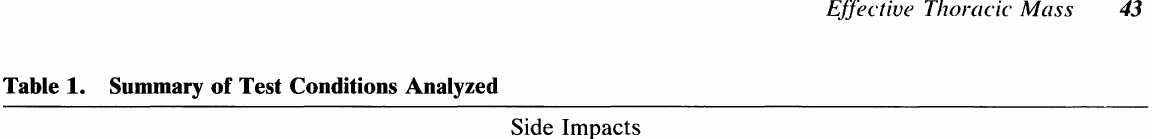
Table 1. Summary of Test Conditions Analyzed Side Impacts Using left and right upper ribs (4th rib) and lower spine (T-12) lateral accelerations. Except as noted, all tests were with the arms